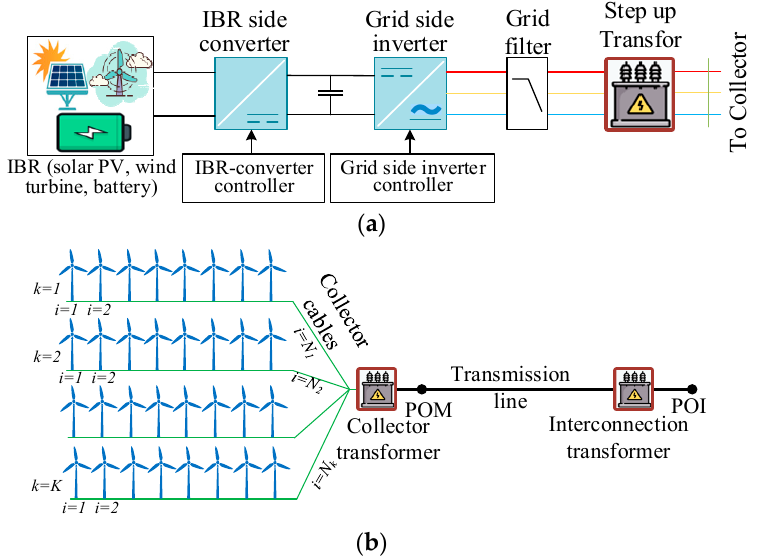
Figure 1. A generalized diagram of ( a ) a full-scale IBR system and ( b ) a grid connected WPP. Similarly, a utility-scale SPP is built with hundreds to thousands of PV panel strings.